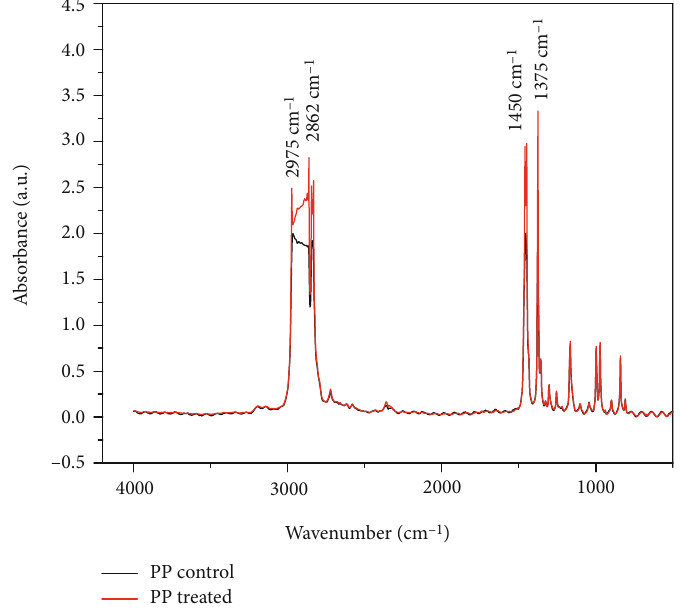
Figure 8: FTIR spectra of untreated and plasma-treated sample of